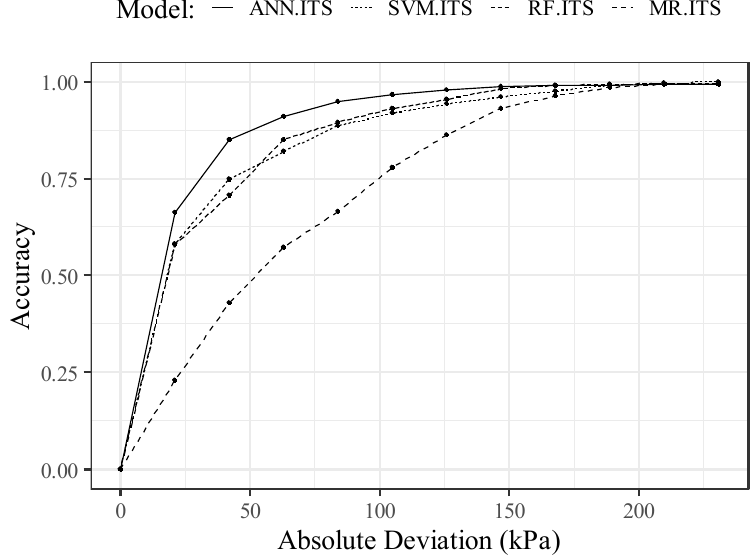
Figure 6. A comparison of ANN.ITS, SVM.ITS, RF.ITS and MR.ITS models performance in ITS pre- diction of soil–binder–water mixtures reinforced with fibers based on REC curves. Figure 7 validates the high performance of both ANN.ITS (Figure 7a) and RF.ITS (Figure 7b) models on ITS prediction. As shown, particularly according to the ANN.ITS model, all predictions are close to the experimental values (diagonal line).